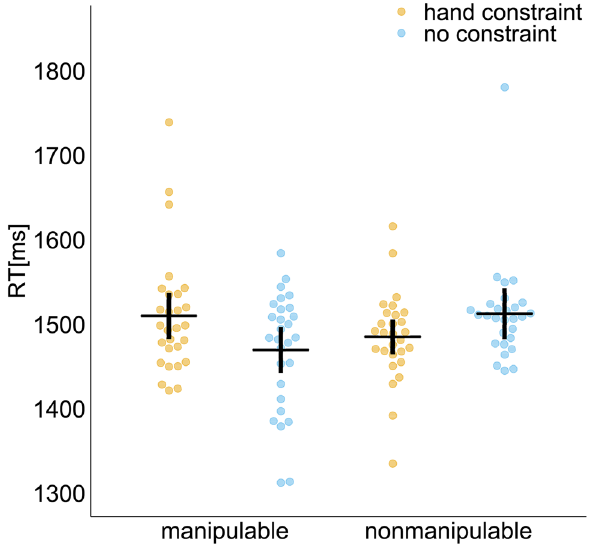
Figure 2. Mean RT (reaction time) in the size judgment task. The orange (hand constraint) and blue (no constraint) dots indicate the mean RT of each participant. Means are presented by horizontal lines. Vertical lines indicate the 95% confidence intervals calculated after subtracting the random effects of participants according to the Cousineau–Morey method 52,53